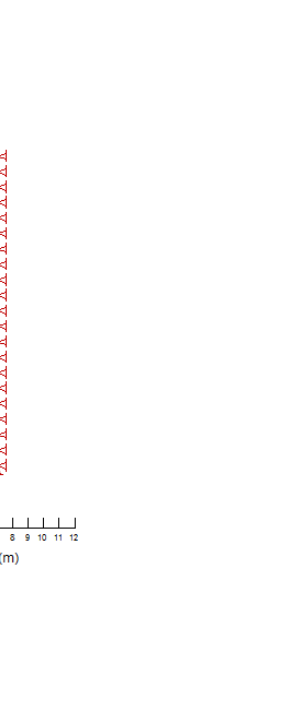
Figure 2. Geometry and mesh of the analysis domain adopted in the code: ( a ) QUAKE/W (the triangles along the boundaries of the soil identify the constraints applied during the static phase) and ( b ) FLAC3D (the soil has a tight mesh compared to the coarse mesh of the bedrock).